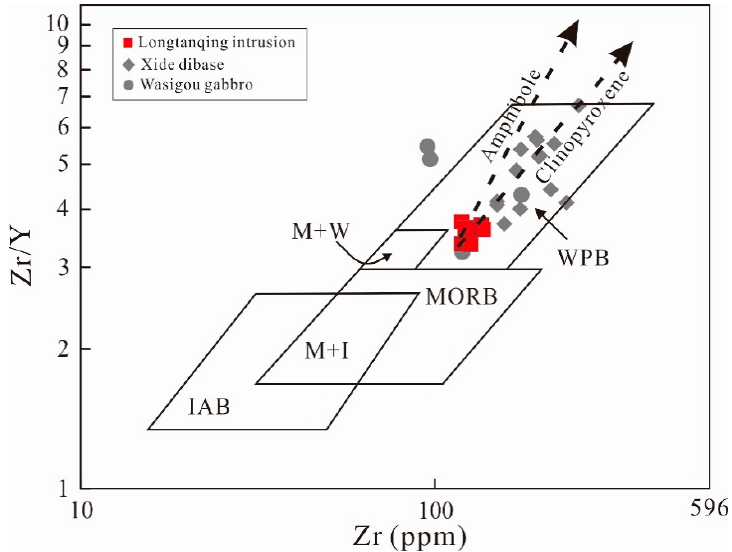
Figure 10. Geochemical discrimination diagram of Zr/Y–Y [96] for the Longtanqing, Xide [42], and Wasigou [22] in the western YZB. IAB—island arc basalt; WPB—within plate basalt; M + I—MORB and island arc basalt; M + W—MORB and within plate basalt.